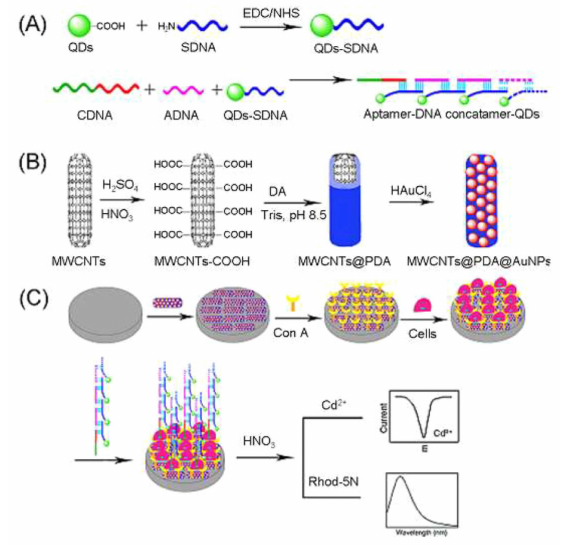
Figure 7. Preparation of nanocomposite-based cytosensors. Precedures for ( A )